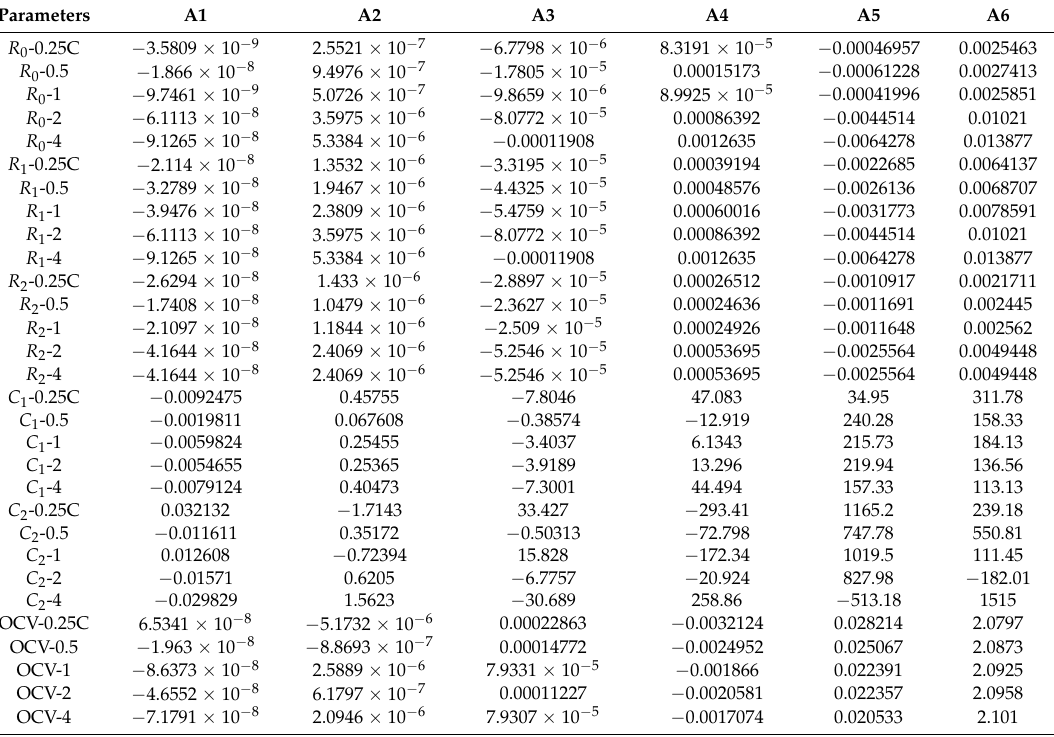
Table 1. Coefficients of fifth order